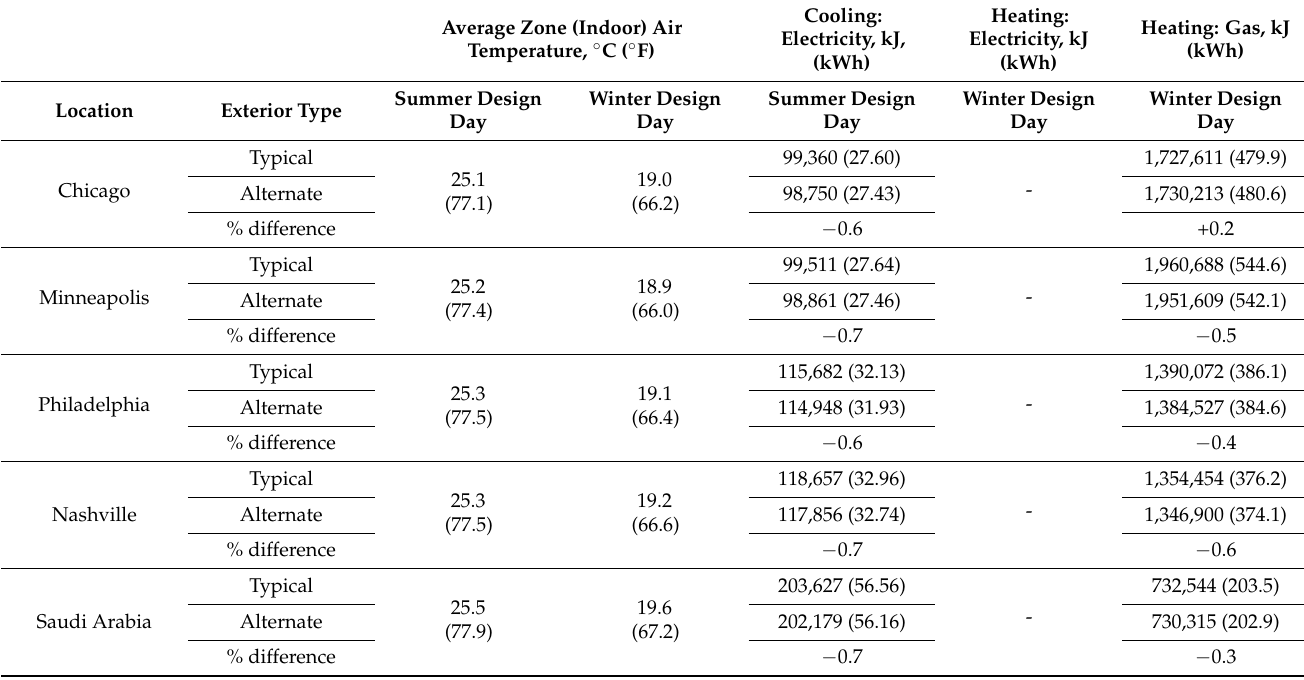
Table 13. Results for supermarket reference model building energy